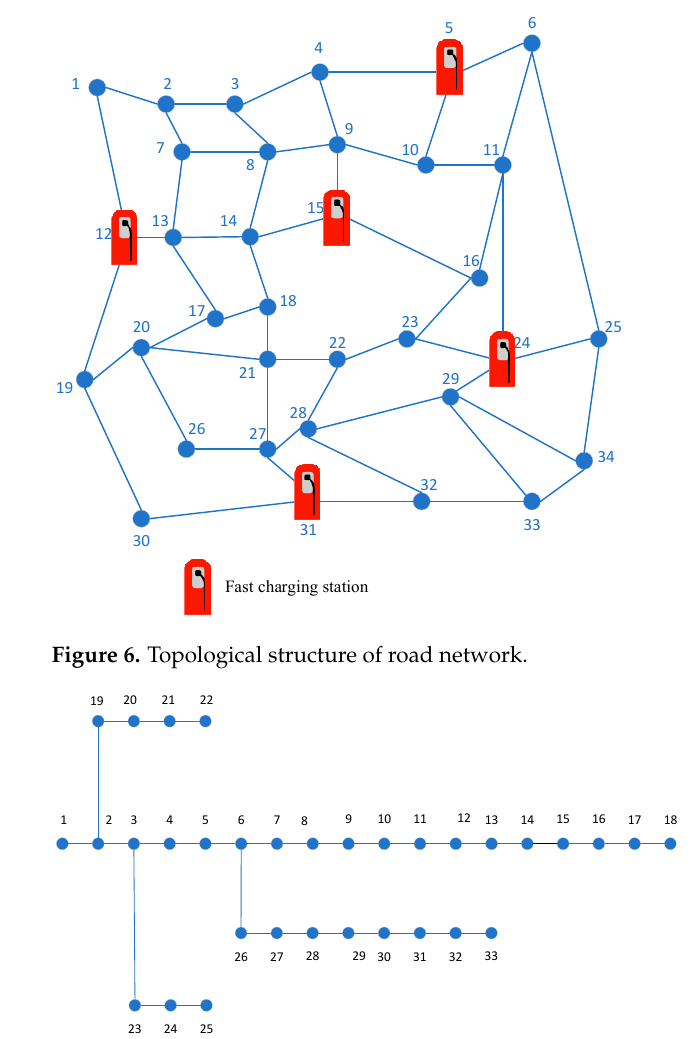
Figure 5. Flow chart of guidance strategy.